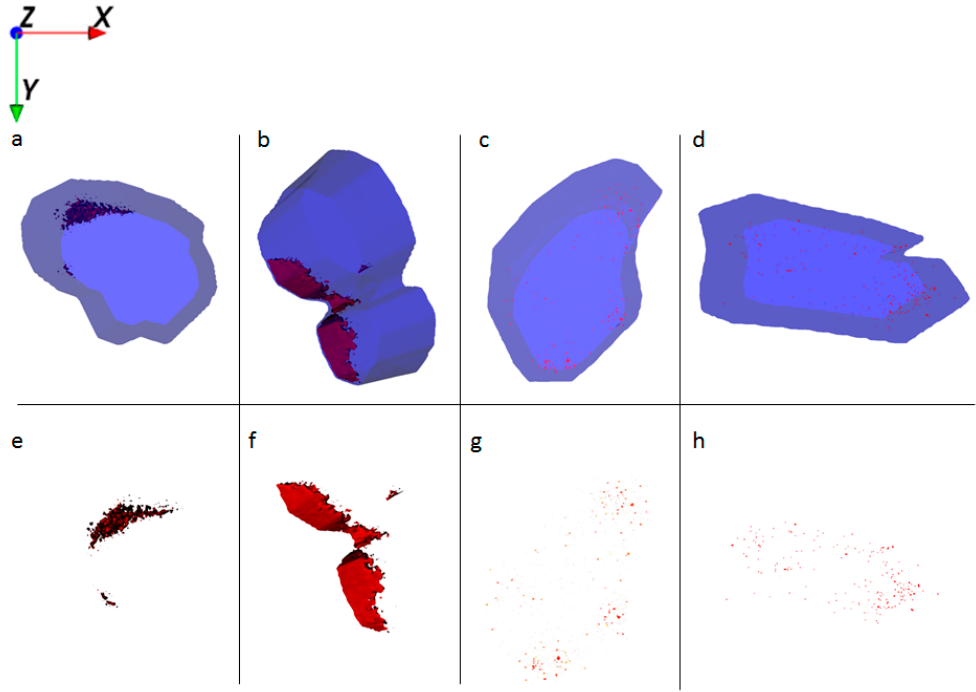
Figure 4. Ion reconstruction of a 3D depth profile (depth layer numbers: 50–250) of one single HaCaT cell, which was exposed to Al 0 NMs for 24 h. The images show the top-down view of the outline of a cell of a depth profile. The translucent blue outline was reconstructed based on the C 3 H 8 N + signal that originates from intracellular amino acids. ( a ) Control cells treated with Al 0 NM only (red color); and corresponding intracellular localization of Al 0 NM agglomerates ( e ). ( b ) Cells treated with retinol and Al 0 NM (red color); and corresponding intracellular localization of Al NM agglomerates ( f ). ( c ) Cells treated with low vitamin D3 and Al 0 NM (red color); and corresponding intracellular localization of Al 0 NM agglomerates ( g ). ( d ) Cells treated with high vitamin D3 and Al 0 NM (red color); and corresponding intracellular localization of Al 0 NM agglomerates ( h ).